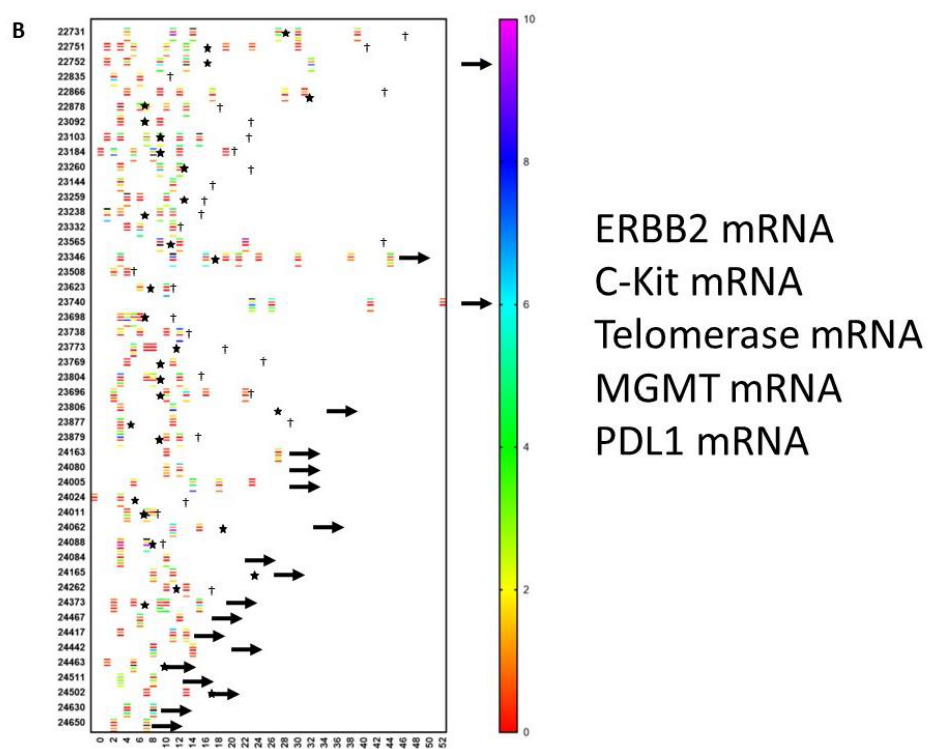
Figure 3. Evolution of oncogene expression in circulating tumor cells. Circulating tumor cells were measured repetitively in 46 patients. Each patient is referenced with a number on the y -axis. Time in months is indicated on the x -axis. The scale of the color of each test is shown on the right-hand side. ( A ) The level of mRNA expression for EGFR is expressed as the ceq (cell equivalent). Most of the values are negative (red). However, as indicated by the arrows, some patients showed an upregulation of EGFR during the disease course. ( B ) This shows a similar data set-up as in panel A. For each patient, data on mRNA expression are relative to the house-keeping gene GADPH and are shown in a particular color, for which the scale is shown on the right-hand side. For each patient, up to five lines are shown at different moments during the disease course. From top to bottom, values for ERBB2, c-Kit, telomerase, MGMT, and PDL1 are shown for each patient. Stars indicate new events. A † indicates when the patient died. An arrow to the right indicates the time at which the patient was censored in the analysis.